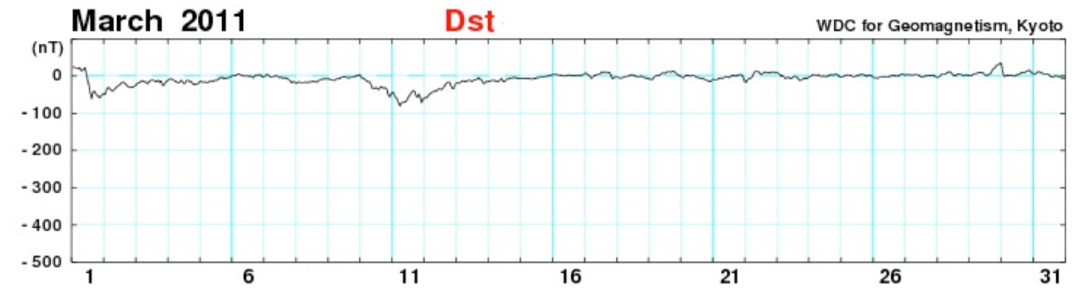
Figure 8. This figure shows the Dst indices in March 2011 (World Data Center for Geomagnetism,